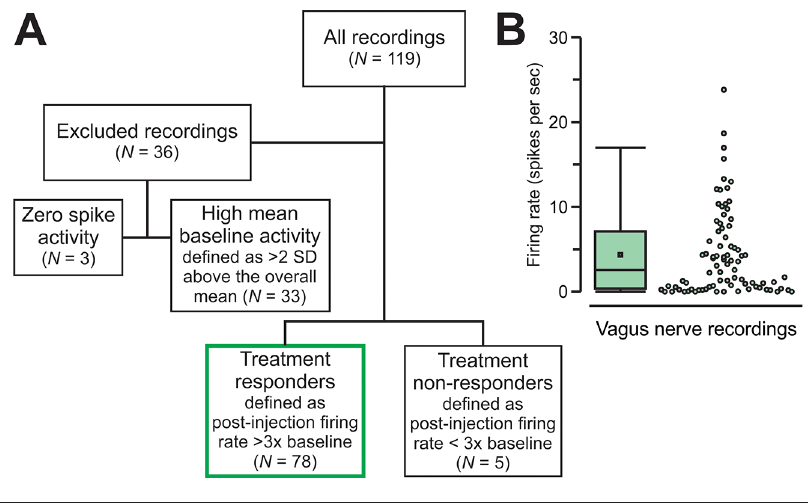
Figure 3. Criteria for selecting vagus nerve recordings for analysis. (A) The diagram shows the inclusion/exclusion criteria used to select experiments for further analysis. From a total of 119 cervical vagus recordings performed in anesthetized mice, 83 recordings lasting > 10 min were selected. (B) The box plot shows the spontaneous activity of the vagus nerve during baseline recording for all the included experiments. Mean CAP frequency of 5.61 ± 0.74 Hz (mean ± SEM, N = 83). Each dot represents a separate